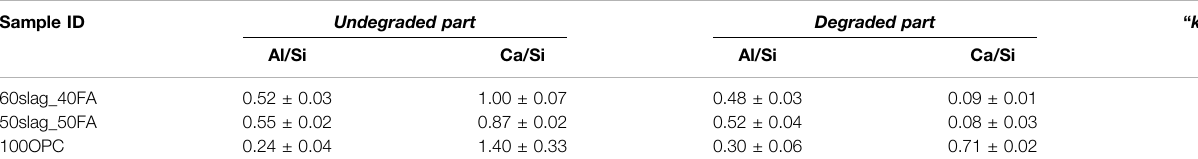
TABLE 4 | Al/Si and Ca/Si atomic mass ratios of samples based on EDX analysis. Sample ID